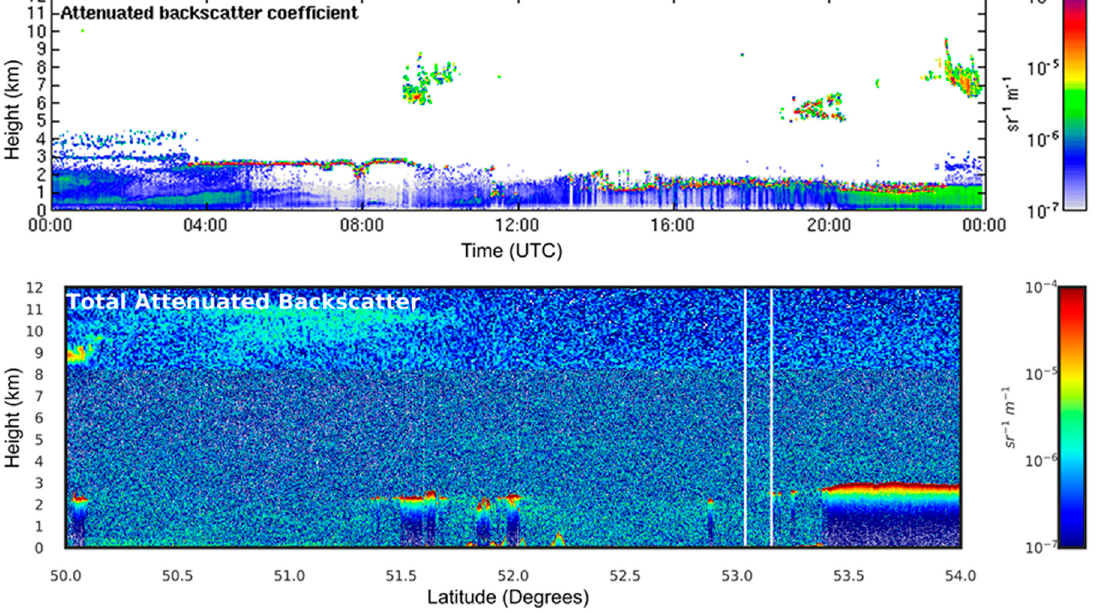
Figure 1. Example of the difference in the sensitivity within different altitude ranges between the Jenoptik CHM15K lidar ceilometer at Mace Head (top) and CALIOP (Cloud–Aerosol Lidar with Orthogonal Polarization) (bottom). The vertical lines in both figures represent the interval chosen for comparison, which is explained in detail in Section 4. Note: The lower end of the color scales are different in Figure 1, although the backscatter values present the same range (10 − 7 sr − 1 km − 1 to 10 − 4 sr − 1 km − 1 ). This difference is associated with the level of noise in the data, which represent by white for the Mace Head image (top) and by blue in CALIOP image(bottom). The ceilometer plot (top) was obtained from Cloudnet.